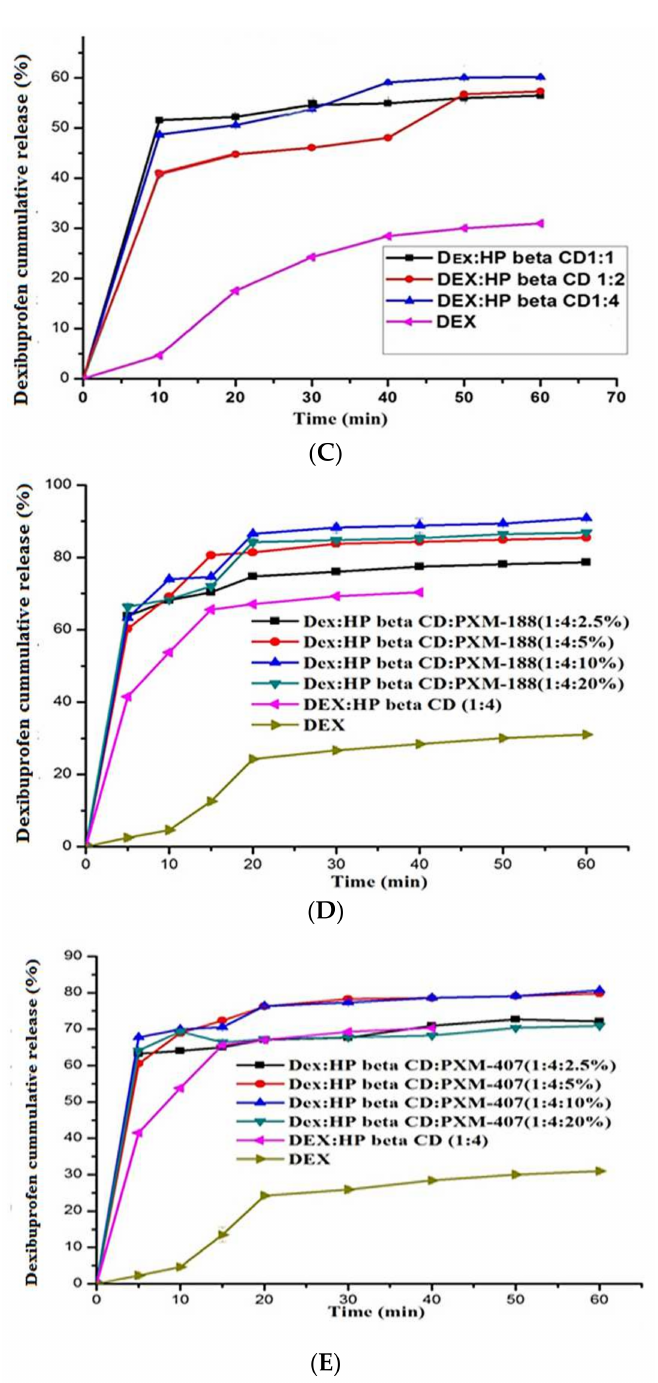
Figure 3. ( A ) Dissolution profiles of DEX and DEX–HP β CD inclusion complexes by PT method Mean ± SD, n =3. ( B ) Dissolution profiles of DEX and DEX–HP β CD inclusion complexes by KN Mean ± SD, n =3. ( C ) Dissolution profiles of DEX and DEX–HP β CD inclusion complexes SE method. Mean ± SD, n =3. ( D ) Dissolution profiles of DEX, binary system and DEX:HP β CD ternary systems with PXM-188. Mean ± SD, n = 3. ( E ) Dissolution profiles of DEX, binary system DEX:HP β CD and ternary systems with PXM-407. Mean ± SD, n =